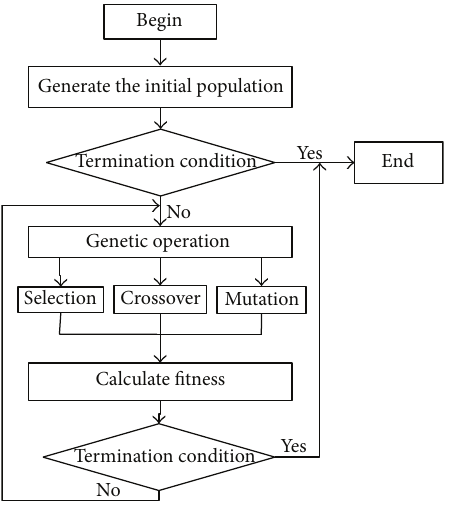
Figure 4: The procedure of the genetic algorithm.